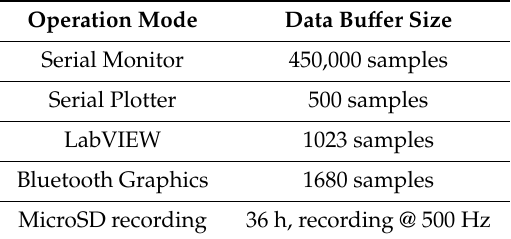
Table 12. Data bu ff er size in each mode of operating / interface for visualization.